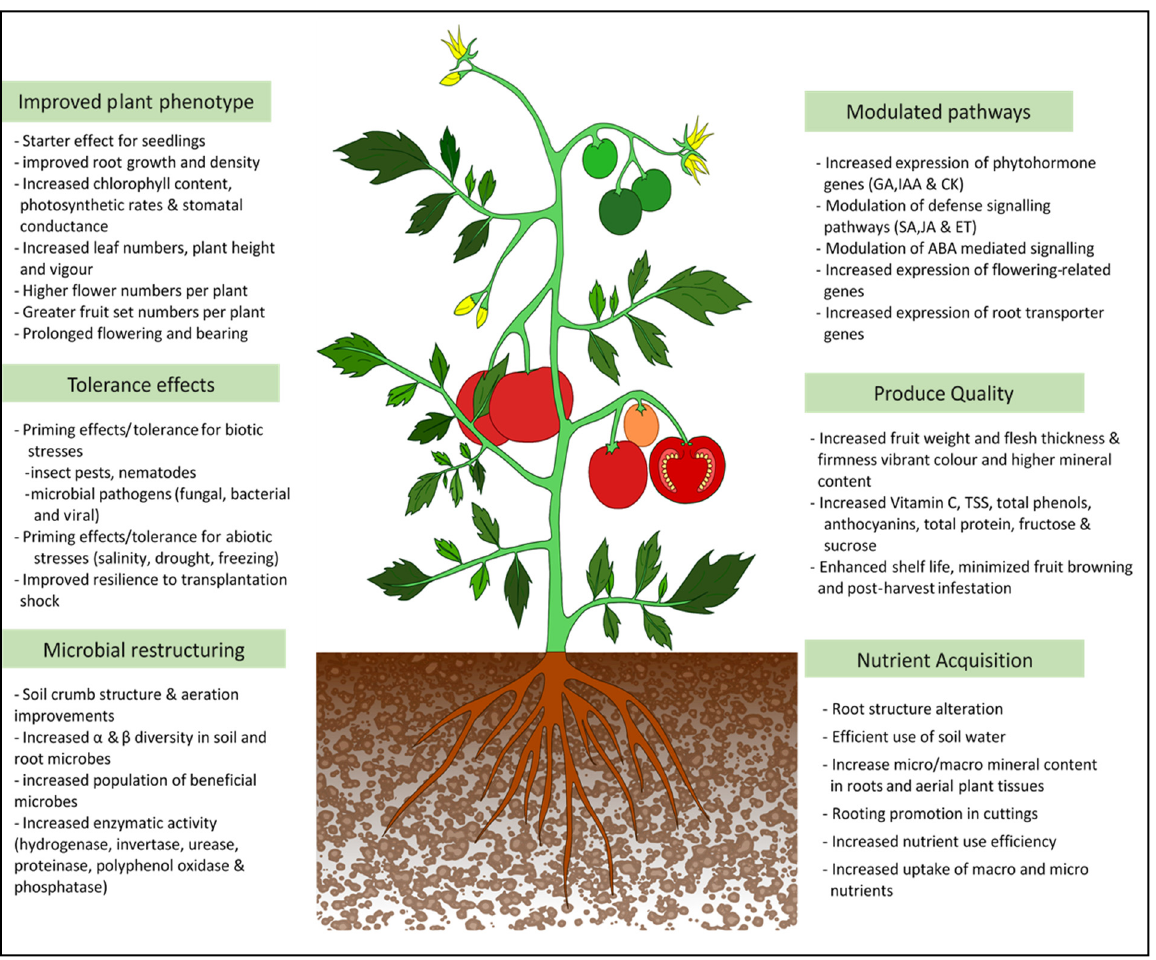
Figure 3. Overview of the positive effects of seaweed extracts on the plant and soil systems. Funding: The preparation of this manuscript was funded by the RDI-IPOC Research Grant, UWI, and Govt. of Trinidad and Tobago to J.J. and A.R.